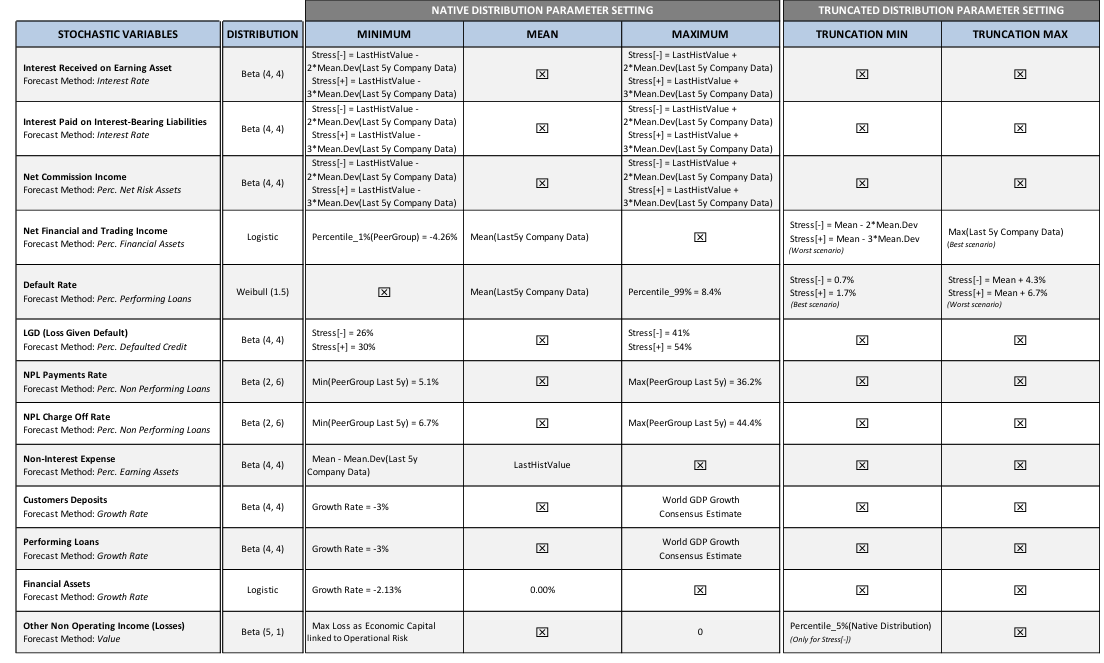
Figure A1. Stochastic variables: modeling & assumptions.